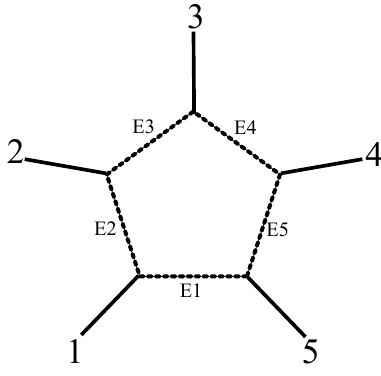
Figure 9 . Pentagon diagram.